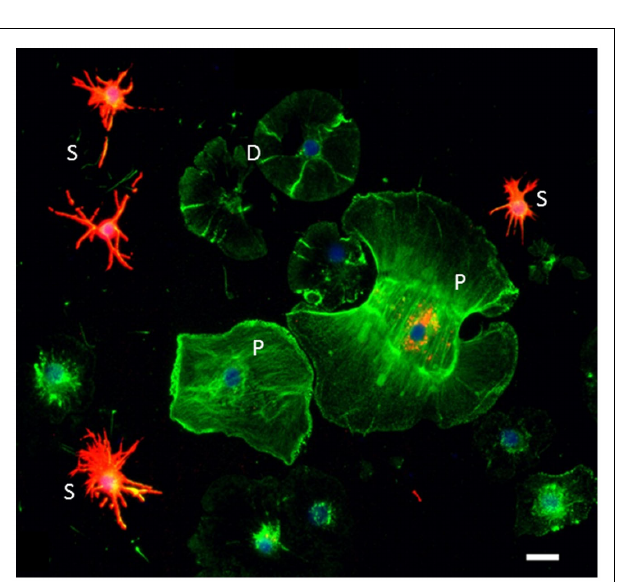
FIGURE 3 | Sp185/333 proteins are expressed by subsets of small phagocytes and polygonal phagocytes. Phagocytes are labeled for actin (green), Sp185/333 proteins (red), and DNA (blue). Small phagocytes (S) have different filopodial morphology and actin organization than the discoidal phagocytes (D) or polygonal phagocytes (P). A subset of small phagocytes are strongly labeled for Sp185/333 proteins.The larger polygonal cell has perinuclear vesicles that are Sp185/333 + . Bar = 10 μ m. This is Figure 1D reproduced from Brockton et al. (2008).